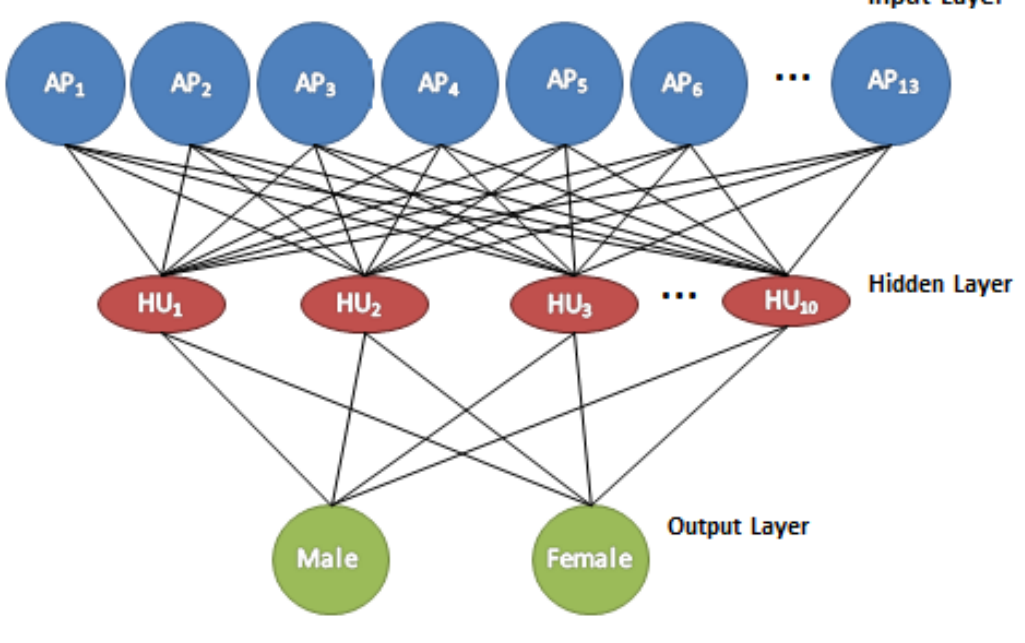
Figure 2. Example of the NN structure used for sex classification. NNs are computer programs that learn to classify various inputs through pattern recognition (Haykin, 1994; Ripley, 2008). They are typically composed of three or more units (neurons), organized into separate processing layers - an input layer, an output layer, and at least one hidden layer. Units in each layer send information to other units through weighted connections, which are automatically modified through training to produce desired outputs (Dawson, 2008; Reby et al., 1997), essentially combining input information (i.e., the 14 acoustic parameters) in all possible ways, via hidden units, to most accurately categorize outputs. The weights of these connections determine which category (e.g., male or female) a NN will select for each whistle. Input layer; AP = acoustic parameter. Hidden layer; HU = hidden